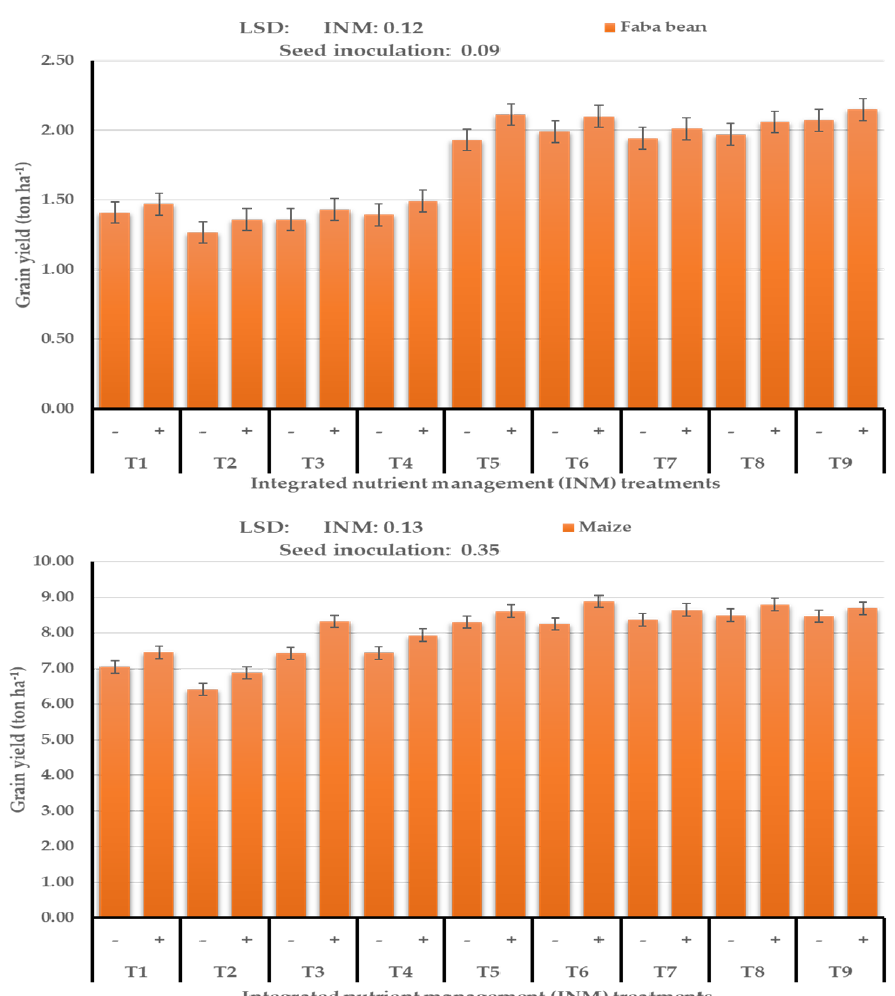
Figure 2. Effects of different integrated nutrient management (INM) on final grain yield of faba bean and maize. Vertical bars indicate standered error ( n = 8). T1, T2, T3, T4, T5, T6, T7, T8, and T9 indicate the treatments of full recommended NPK, compost of cow manure at 5 t ha −1 , compost of poultry litter manure at 5 t ha −1 , compost of mixture of sheep and camel manure at 5 t ha −1 , 50% NPK + 5 t ha −1 mixture of three types of compost, 50% NPK + 10 t ha −1 mixture of three types of compost, mixture of three types of compost at 10 t ha −1 , mixture of three types of compost at 15 t ha −1 , and mixture of three types of compost at 20 t ha −1 , respectively. (+) and (−) indicate with and without seed inoculation, respectively.